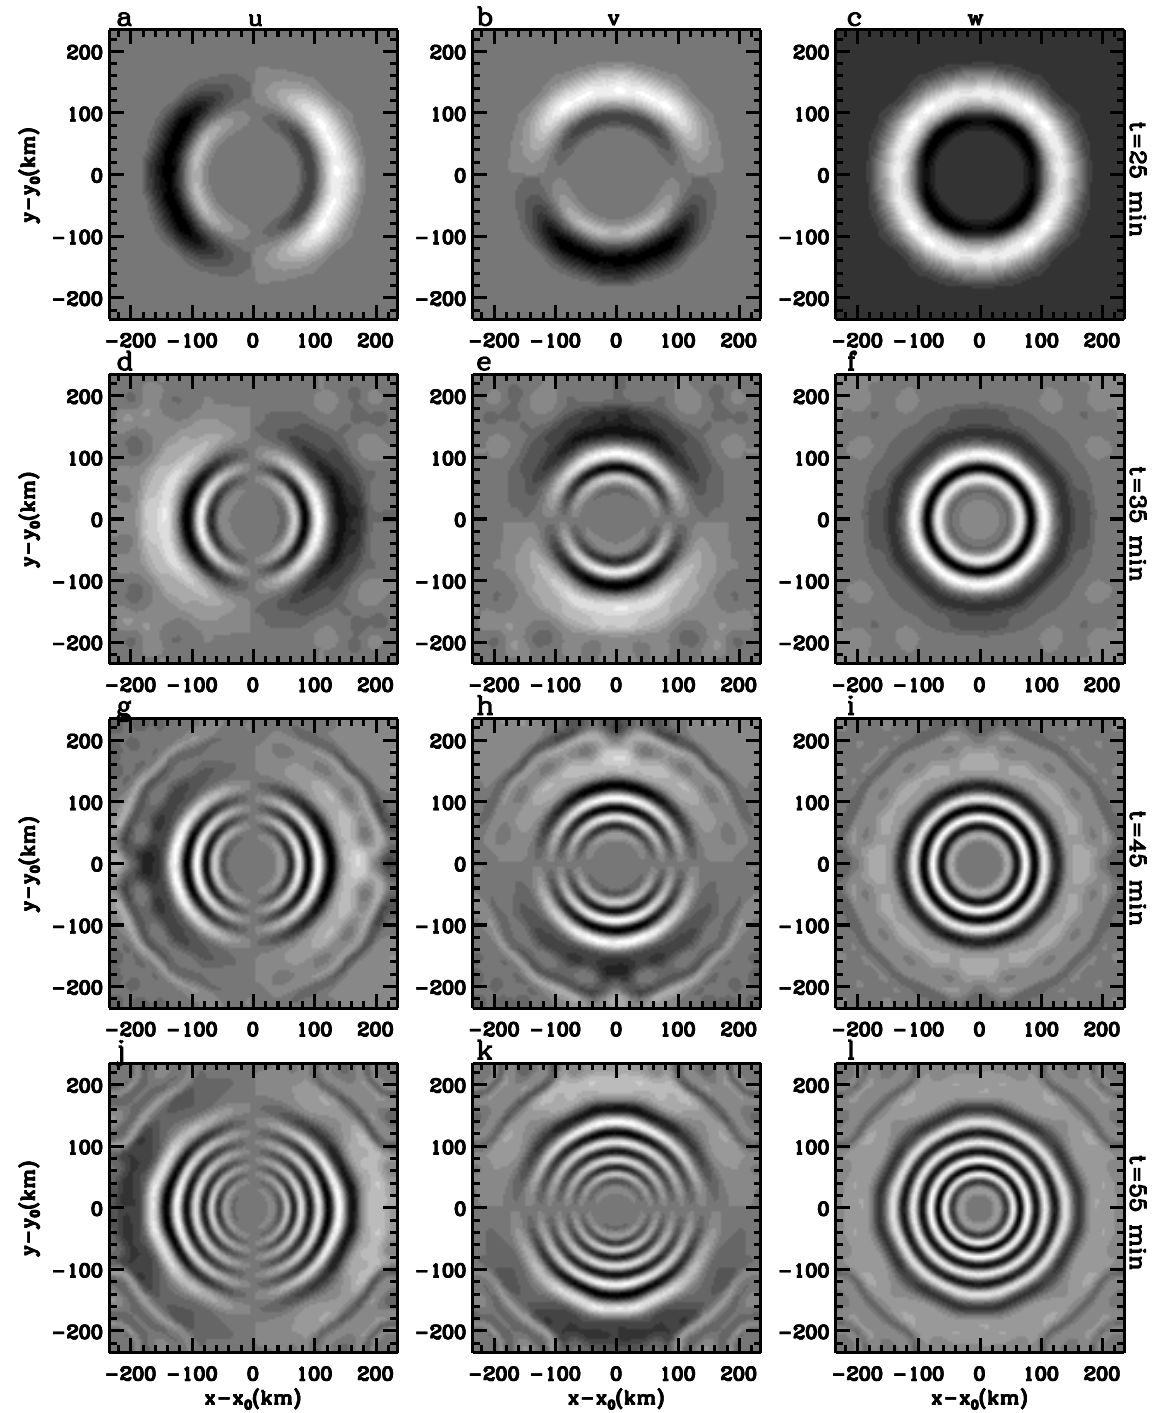
Fig. 12. Horizontal slices of the reconstructed u , v and w fields in columns 1, 2, and 3, respectively, from the solutions shown in Fig. 9 at z = 70km. Here, we show the results at t = 25, 35, 45, and 55min in the upper to lower rows, respectively. From left to right, the maximum values of u and w are: 1st row: 3 and 2ms − 1 . 2nd row: 15 and 11ms − 1 . 3rd row: 17 and 12ms − 1 . 4th row: 14 and 9ms − 1 . The maxima for the v images are identical to those of the u